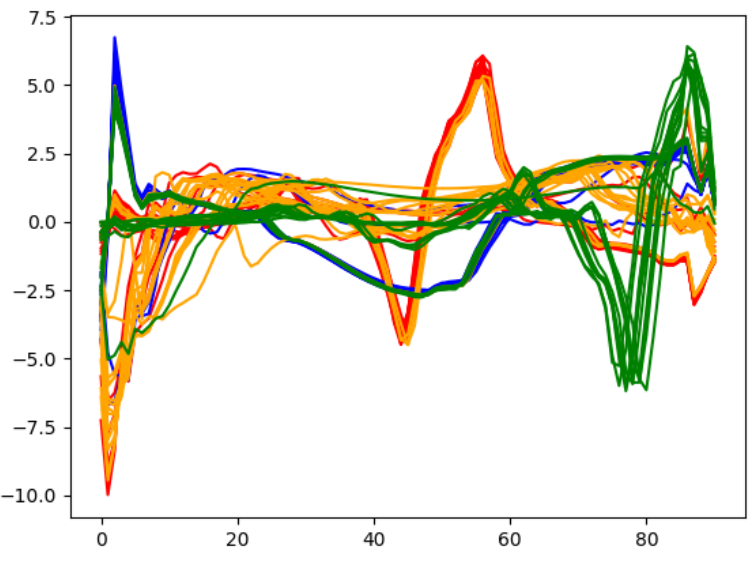
Figure 11. Some features extracted from the autoencoding